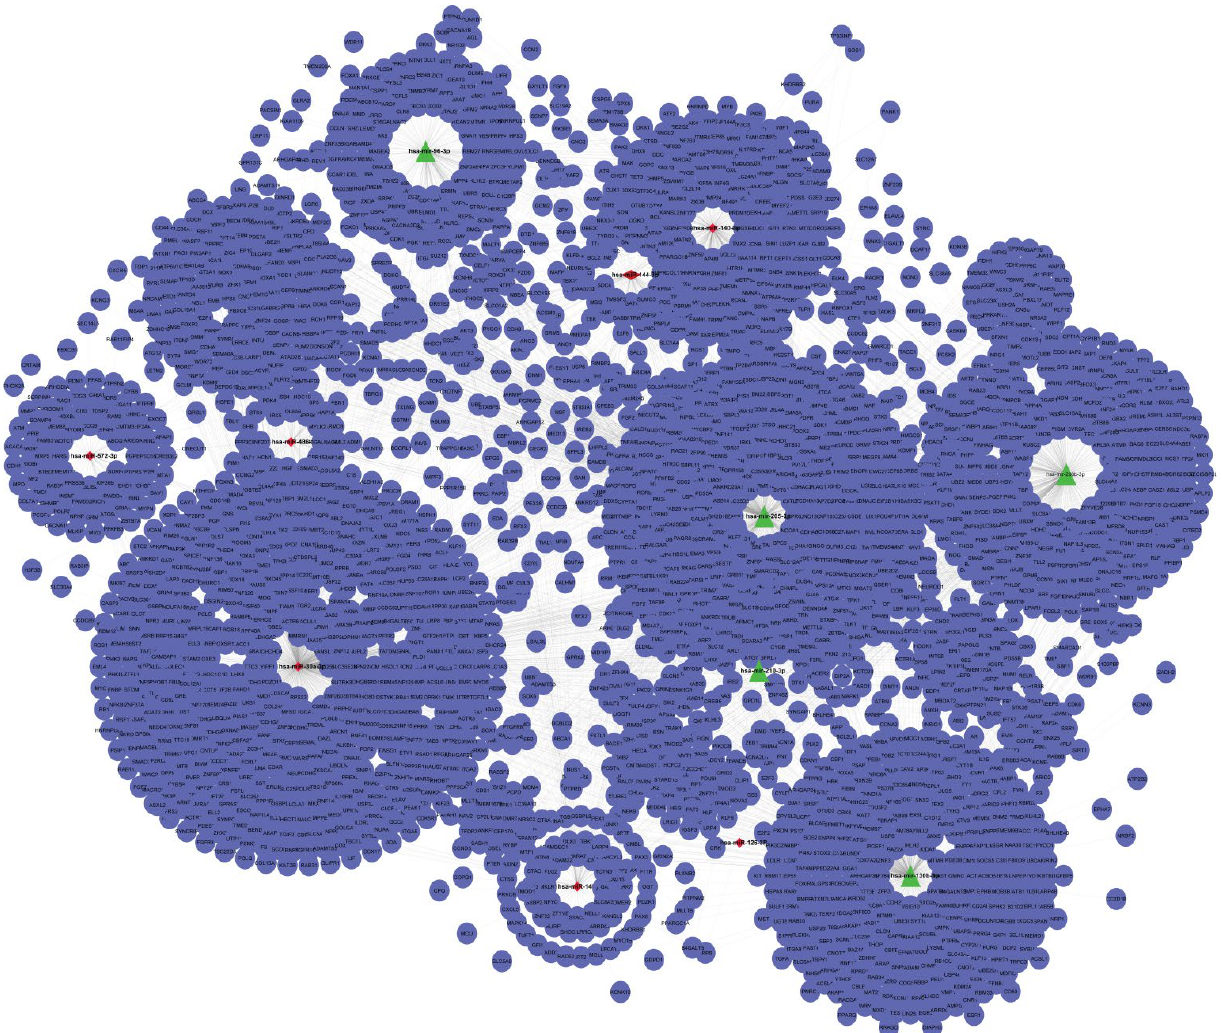
Figure 3. MiRNA-mRNA interaction merge network. The interaction network is constructed with the upregulated and downregulated DEMs using Cytoscape software. The miRNA-mRNA consists of 2970 nodes and 4184 edges. Triangle (green) represents upregulated miRNAs, diamond (red) represents downregulated miRNAs, and circle (blue) represents the interacting partners.